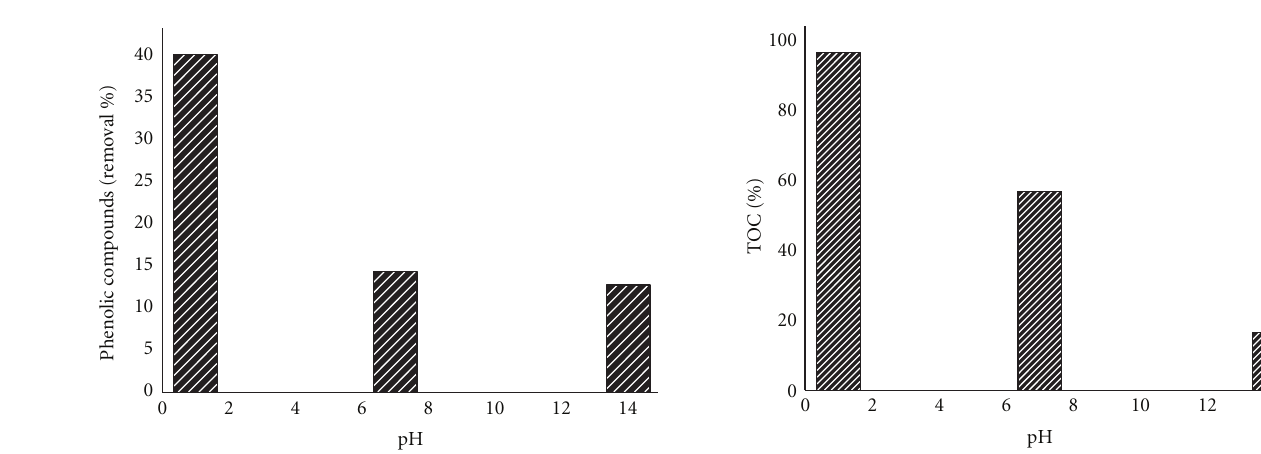
Figure 2: Removal of phenolic compounds in pretreated industrial samples at di ff erent pH values (1, 7, and 14), under constant stir- ring, using BDD and Ti as anode and cathode. 2A ( j = 0 . 32Acm − 2 ) for 60 minutes of electrolysis were applied.